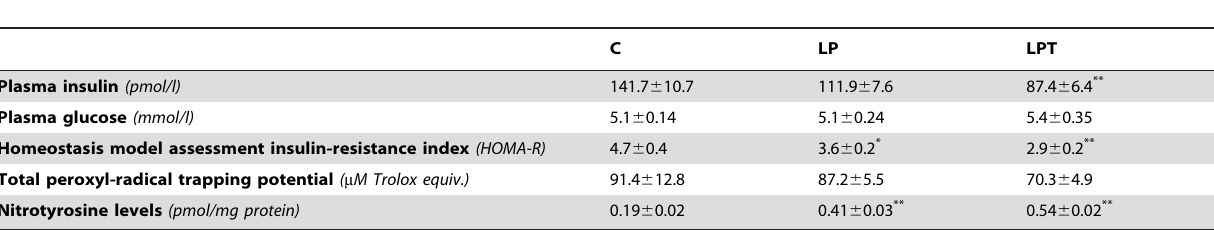
Table 2. Blood analysis in 3 month-old male